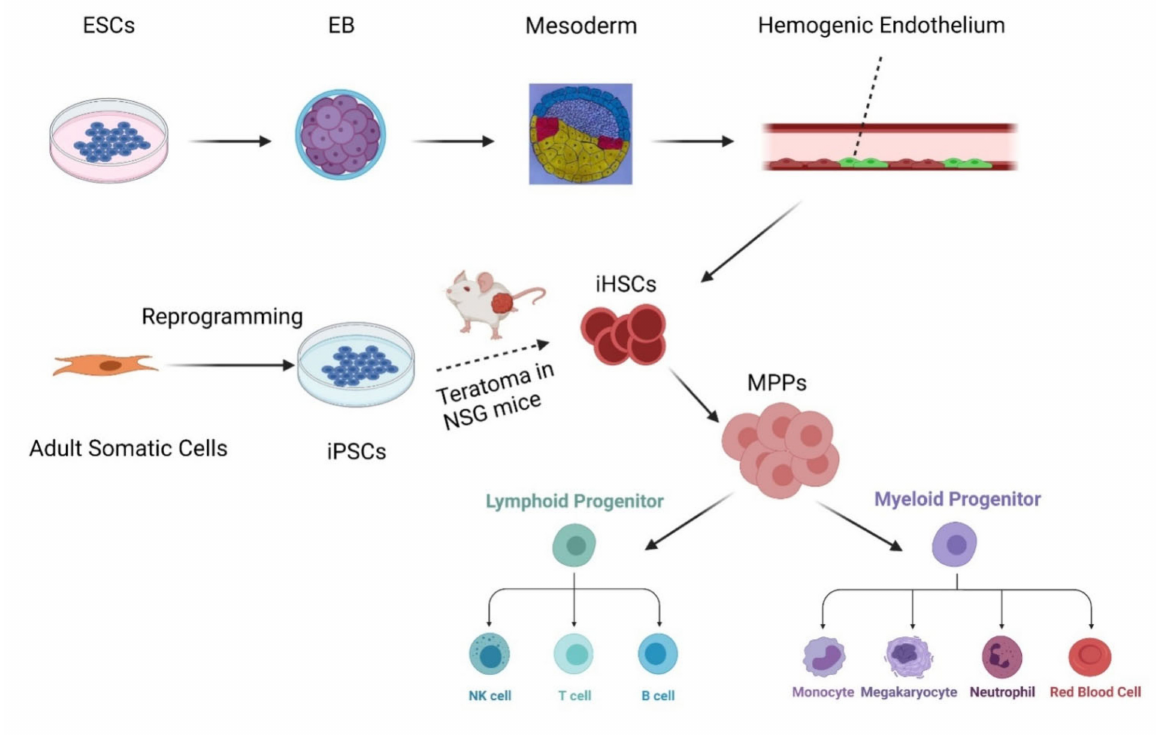
Figure 1. HSCs emerge either via embryo-derived HE or via iPSCs. Induced HSCs can differentiate into MPPs and then into lymphoid and myeloid progenitors, which finally maturate into NK/T/B cells or mono- cytes/megakaryocytes/neutrophils/red blood cells, respectively. ESCs: embryonic stem cells; EB: embryoid body; HE: hemogenic endothelium; iPSCs: induced pluripotent stem cells; iHSCs: induced hematopoietic stem cells; MPPs: multipo- tent progenitors. (The figure was created with BioRender.com (accessed on 24 October